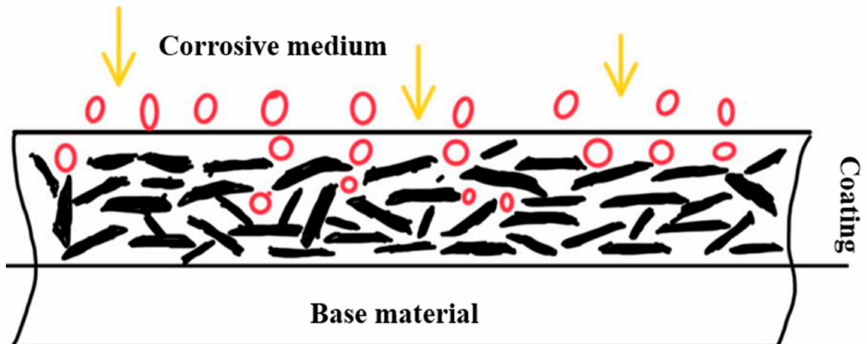
Figure 4. Schematic diagram of graphene corrosion protection